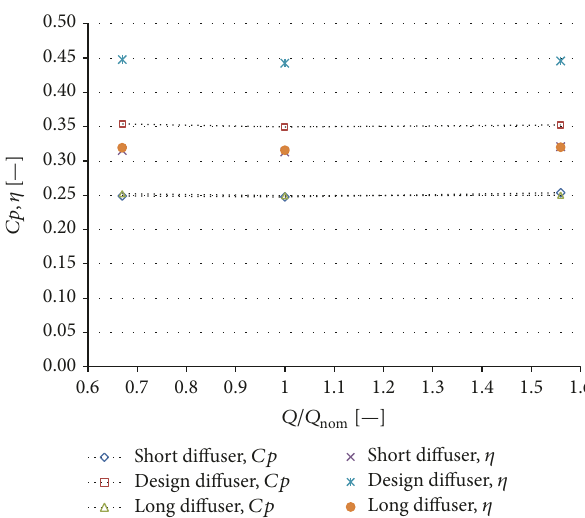
Figure 12: Pressure drop across the diffuser.